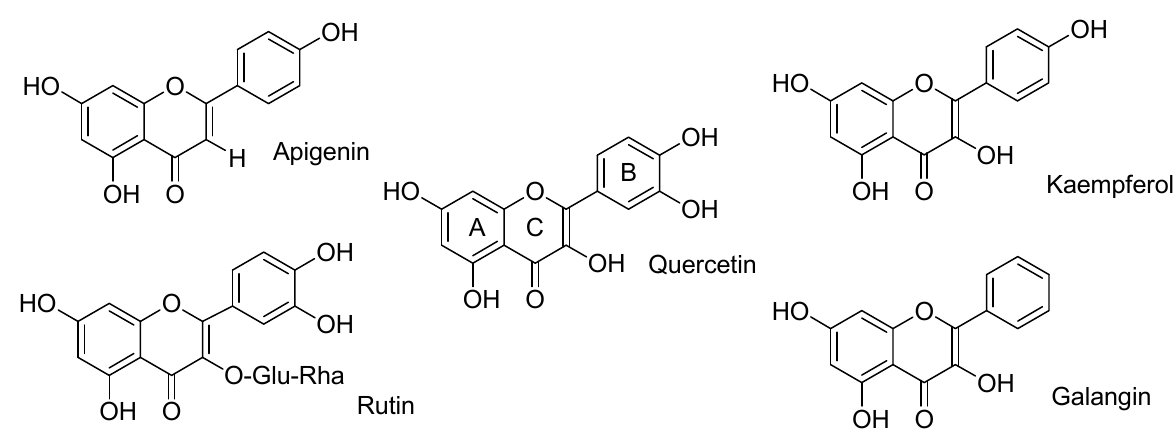
Figure 1. Structures of the studied